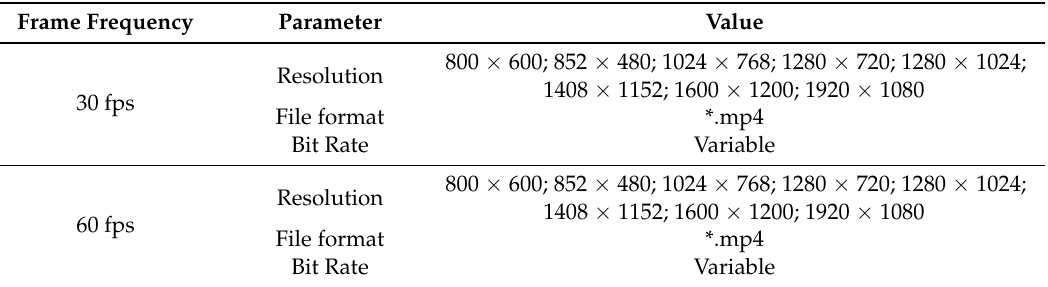
Table 1. Parameters of videos.